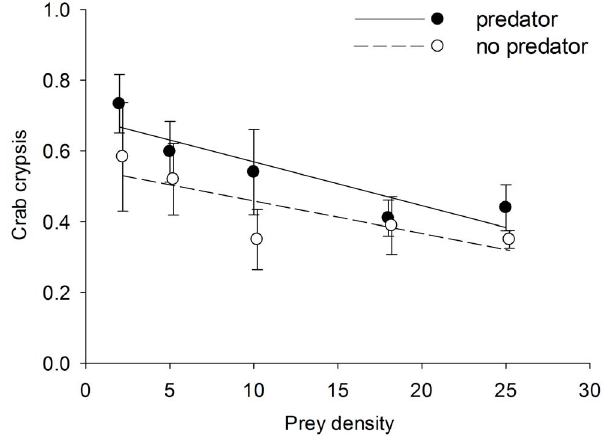
Figure 4. Average ( ± SE) predator crab activity in sand and shell habitat. We define ‘‘motionless’’ as crabs not moving, ‘‘walking’’ as crabs moving laterally, and ‘‘foraging’’ as crabs consuming prey or crabs with repeated movements of chelae from the substrate to the mouth. Different letters indicate statistical significance between habitats for each behavior (t test, p #